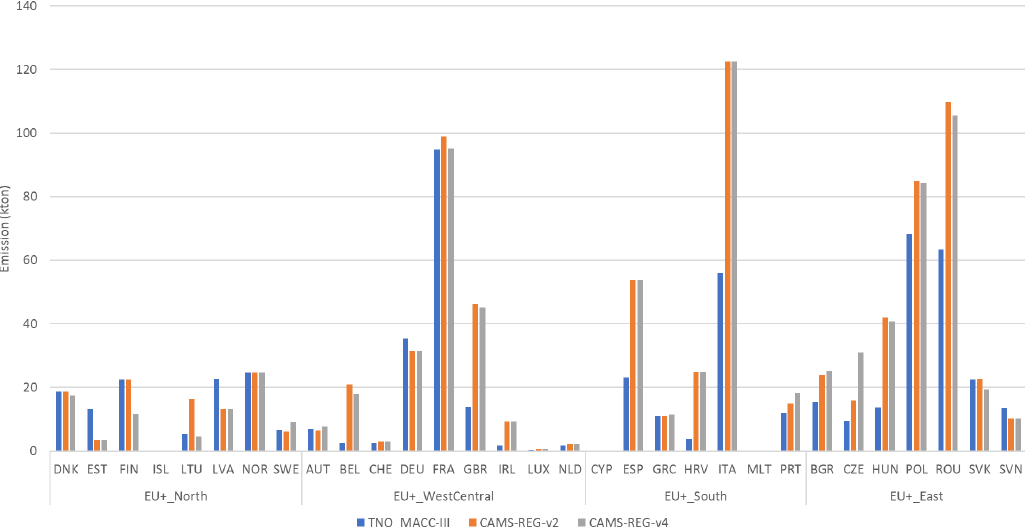
Figure 9. PM 2 . 5 emissions from small combustion (GNFR C) in TNO_MACC-III, CAMS-REG-v2 and CAMS-REG-v4 for the year 2010 and EU +